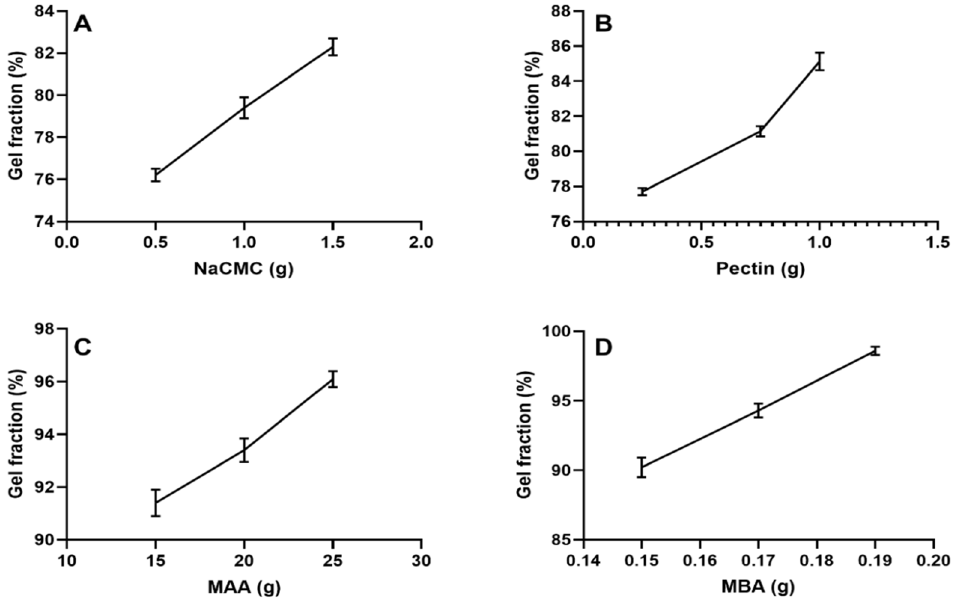
Figure 8. Effect of ( A ) Na-CMC, ( B ) pectin, ( C ) methacrylic acid (MAA), and ( D ) methylene bisacrylamide (MBA) on gel fraction .